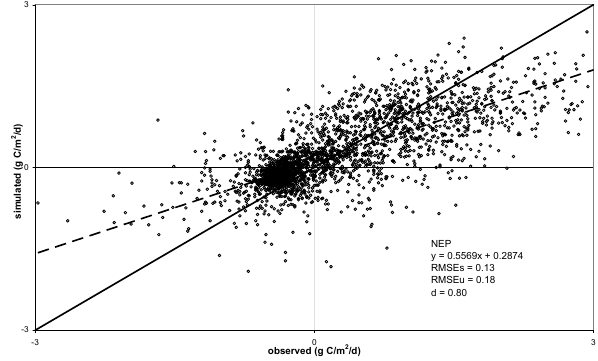
Fig. 5. The scatter plot of observed and simulated daily NEP for 1999–2006. The solid black line indicates the 1:1 line and the dashed line is the best fit relationship between the observations and the simulated